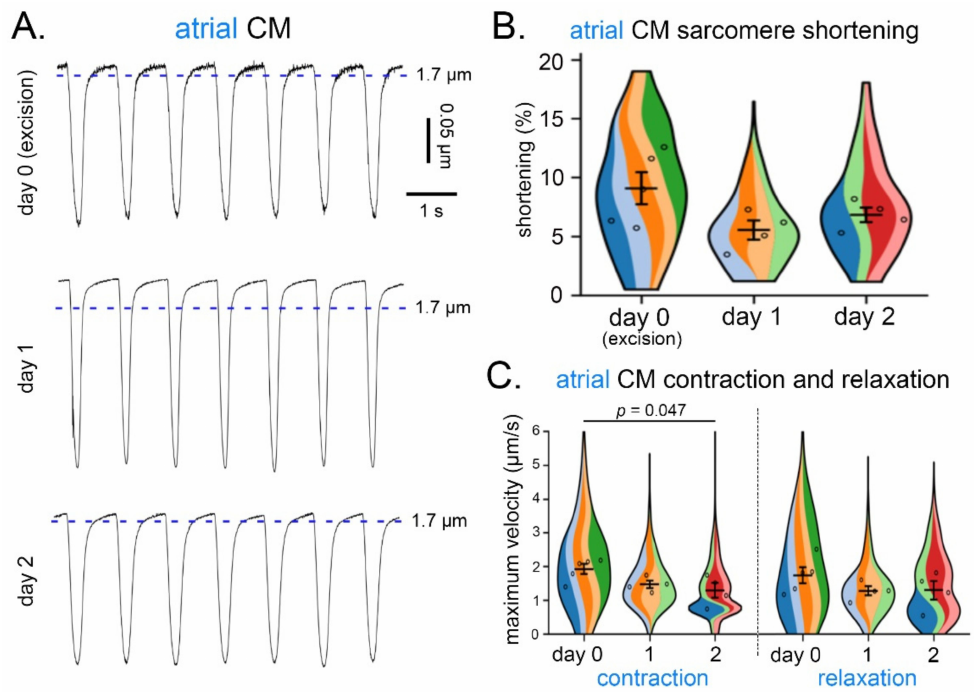
Figure 5. Contraction and relaxation of atrial CM over three consecutive days of cell isolation from live cardiac tissue slices of the same heart. ( A ) Recordings of sarcomere shortening (in response to field stimulation at 1 Hz) over three consecutive days of CM isolation from the same heart. ( B ) Degree of sarcomere shortening (%) in atrial CM (free wall and appendage combined) over three days of CM isolation. ( C ) Maximum velocity of contraction and relaxation in atrial CM (free wall and appendage combined) over three consecutive days of CM isolation; n = 4–5 hearts, 40–70 CM/day of isolation. ( B , C ), each color represents data from one heart. Within each colored area, the open circles represent the average of all cells recorded from the same heart.